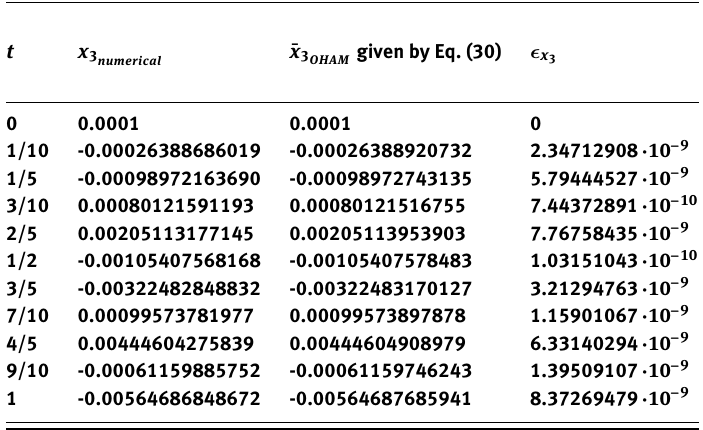
Table 2. The comparison between the approximate solutions ¯ x 5 given by Eq. (32) and the corresponding numerical solutions for M = 15 and P = 20 (relative errors: (cid:15) x